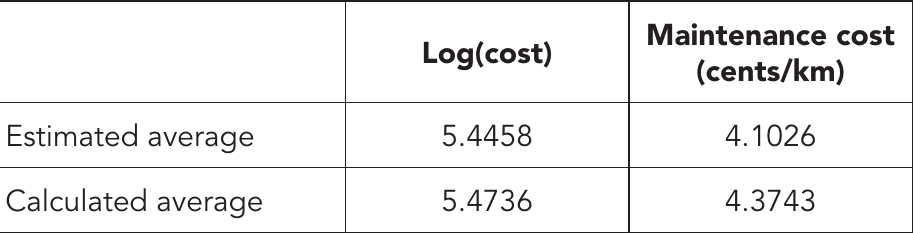
The same approach was followed with a different subset of the data and Table 2 shows the results of this comparison. Table 2: Model evaluation – second subset used for evaluation (Carstens, 2000: 241)